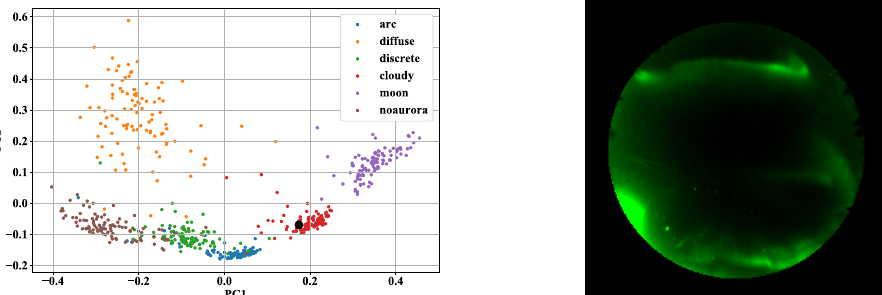
Figure 6. Analysis results of all training data. This shows an image that is identified as cloudy on the cluster but is actually the moon. The large black dot on the graph indicates the embedding to which this image